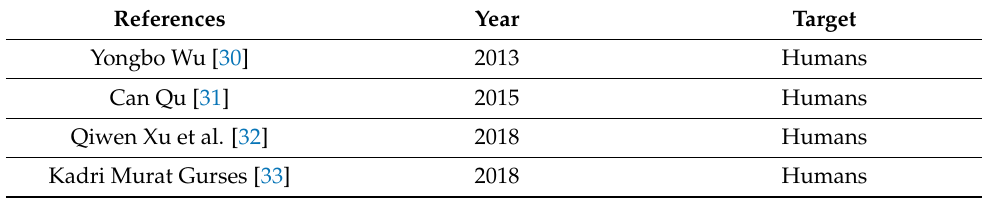
Table 2. Studies evaluating HMGB1 proteins.